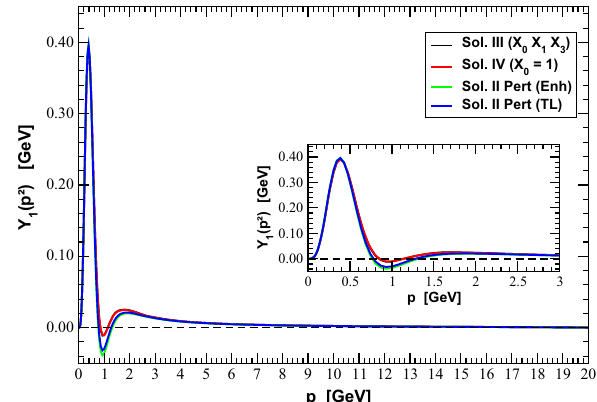
Fig. 28 The quark-ghost kernel form factor Y 1 ( p 2 )